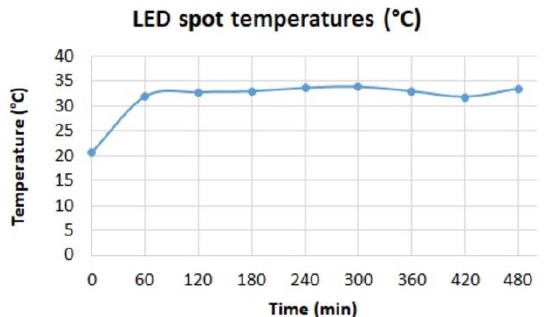
Figure A5. Measured temperature profile at one of the LEDs in room 3 after the LED was switched on.